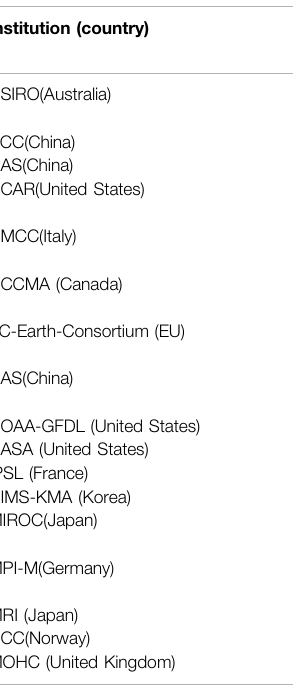
TABLE 1 | Details of the 25 CMIP6 models used in this